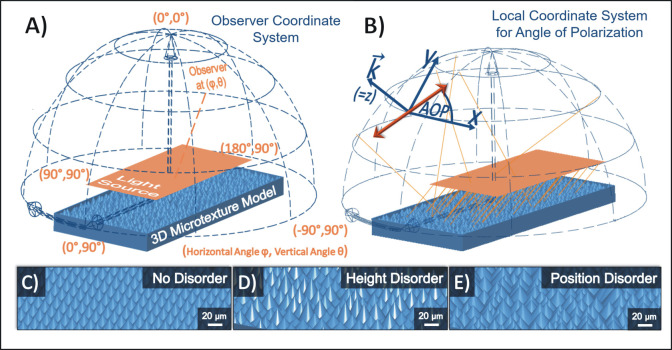
Illustration of a ray-tracing-based simulation approach for studying the properties of light reflected from densely packed and disordered microtextures.A) Definition of the spherical coordinate system for characterizing the observer’s viewing directions in the farfield. The planar rectangular and transparent light source is marked by an orange rectangle. It emitted 108 parallel and unpolarized rays of identical initial power with random starting positions into the central part of the microtexture models. B) At every observer viewing direction (φ, θ), the incoming rays’ (exemplary ray paths are drawn as faint orange lines) propagation direction k defines the z-axis of a local coordinate system that is used for measuring the angle of polarization (noted AOP in the figure). The y-axis is chosen parallel to the local φ = constant line. The angle of polarization of the electric field vector of light represented by an orange double-headed arrow is then always measured relative to the local x-axis (mathematically positive). The array of parallel orange lines under the orange rectangle represents parallel sun rays arriving from an intermediate elevation near an azimuth of 180°. C)-E) depict exemplary microtexture models (cone’s aspect ratio = 0.6, full tiling of the base) illustrating three extreme cases, namely the disorder-free configuration (C), the maximum degree of height disorder (D) and the maximum disorder in the cones’ horizontal position (E).